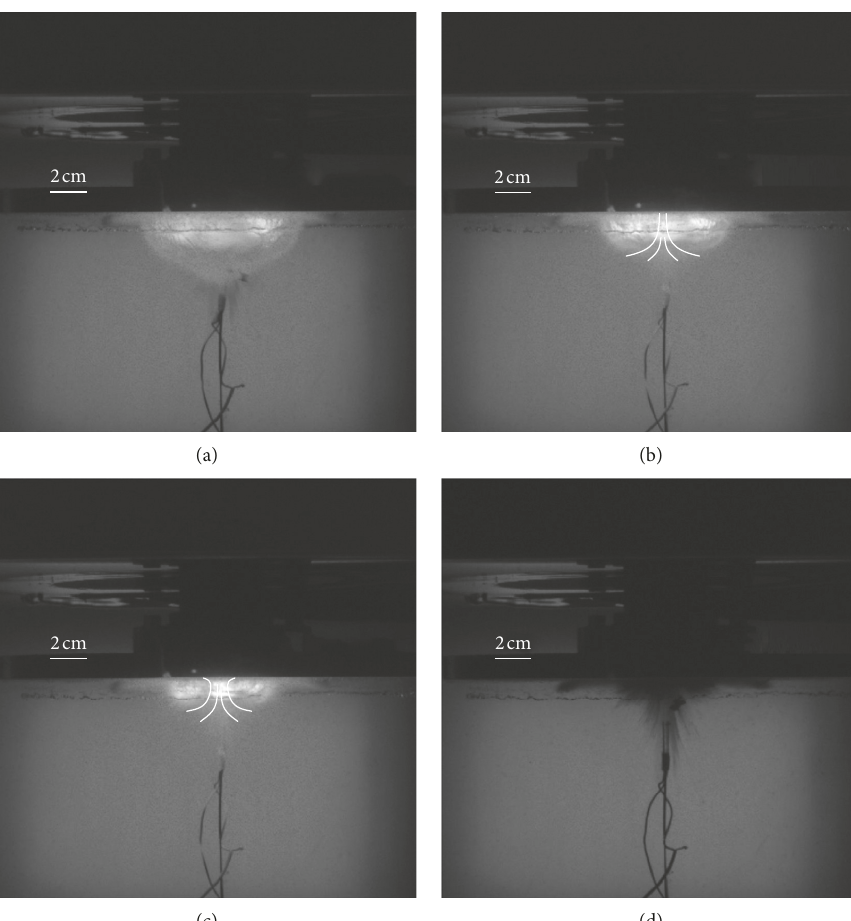
Figure 16: Evolution of the jet and collapse of the underwater bubble below the target plate with 25mm stand-off. (a) t � 15.2060 ms. (b) t � 15.6060ms. (c) t � 15.8560ms. (d) t �